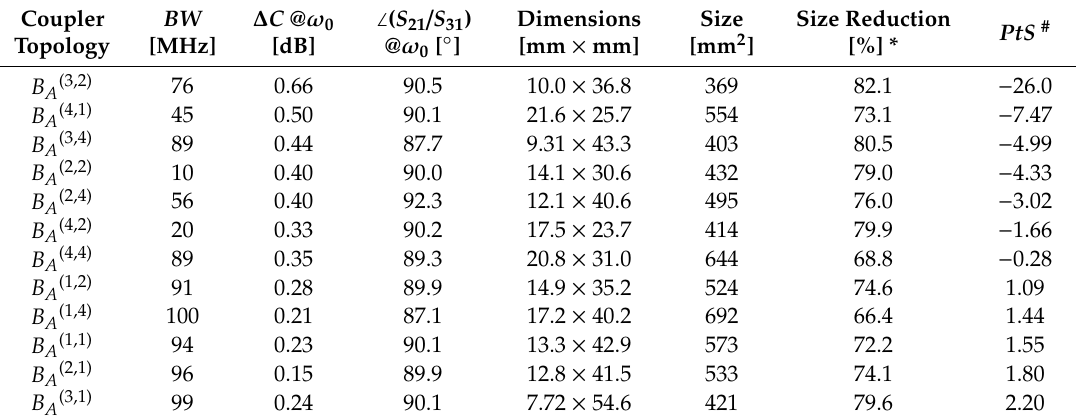
Table 2. Performance comparison of optimized compact BLCs.